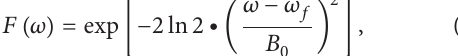
The first and second terms on the right-hand side (RHS) of (1) represent the m th-order dispersion and loss, respec- tively. The third term includes SPM, self-steepening, opti- cal shock formation, and intrapulse Raman scattering. The response function 𝑅(𝜏) = (1−𝑓 𝑅 )𝛿(𝜏)+𝑓 𝑅 ℎ 𝑅 (𝜏) includes both instantaneous electronic and delayed Raman contributions, with 𝑓 𝑅 = 0.18 representing the contribution of Raman response to the instantaneous nonlinear polarization, and (𝜏) = (𝜏 12 + 𝜏 22 )/(𝜏 𝜏 22 ) exp (−𝜏/𝜏 ) sin (−𝜏/𝜏 ) is Raman ℎ 𝑅 1 2 1 response function of silica fiber, where 𝜏 1 = 12.2 fs and 𝜏 2 = 32